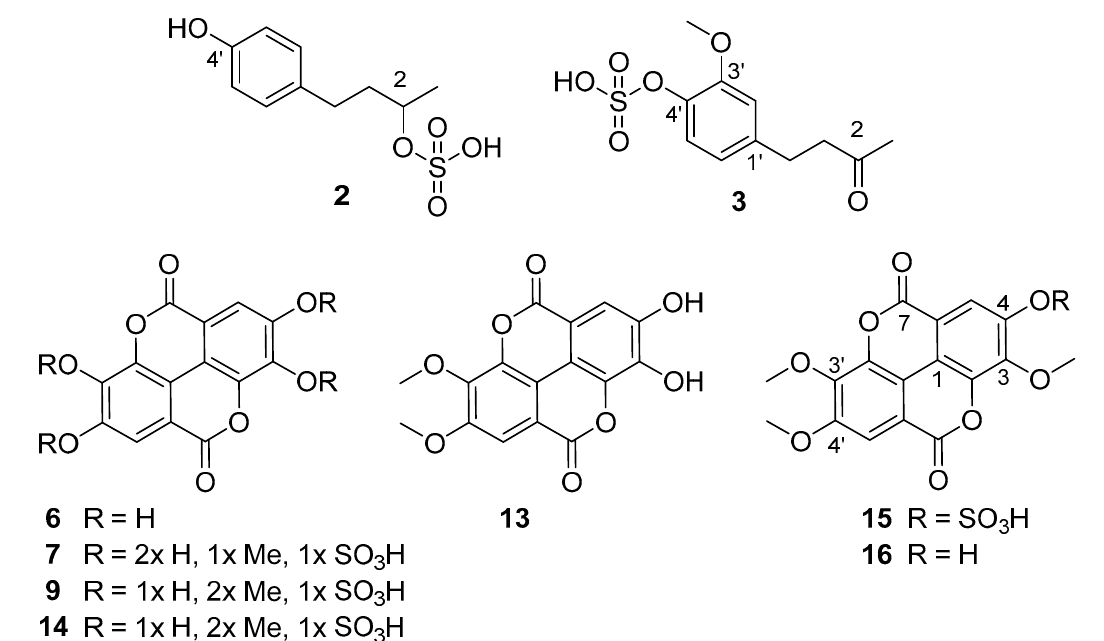
Figure 3. Ellagic acid derivatives and phenylbutanoides detected in root samples from Lumnitzera littorea and L. racemosa . The location of methyl and sulfate residues in compounds 7 , 9 and 14 is not determined. Compound numbers refer to peak numbers shown in Figure 2/Table 1.